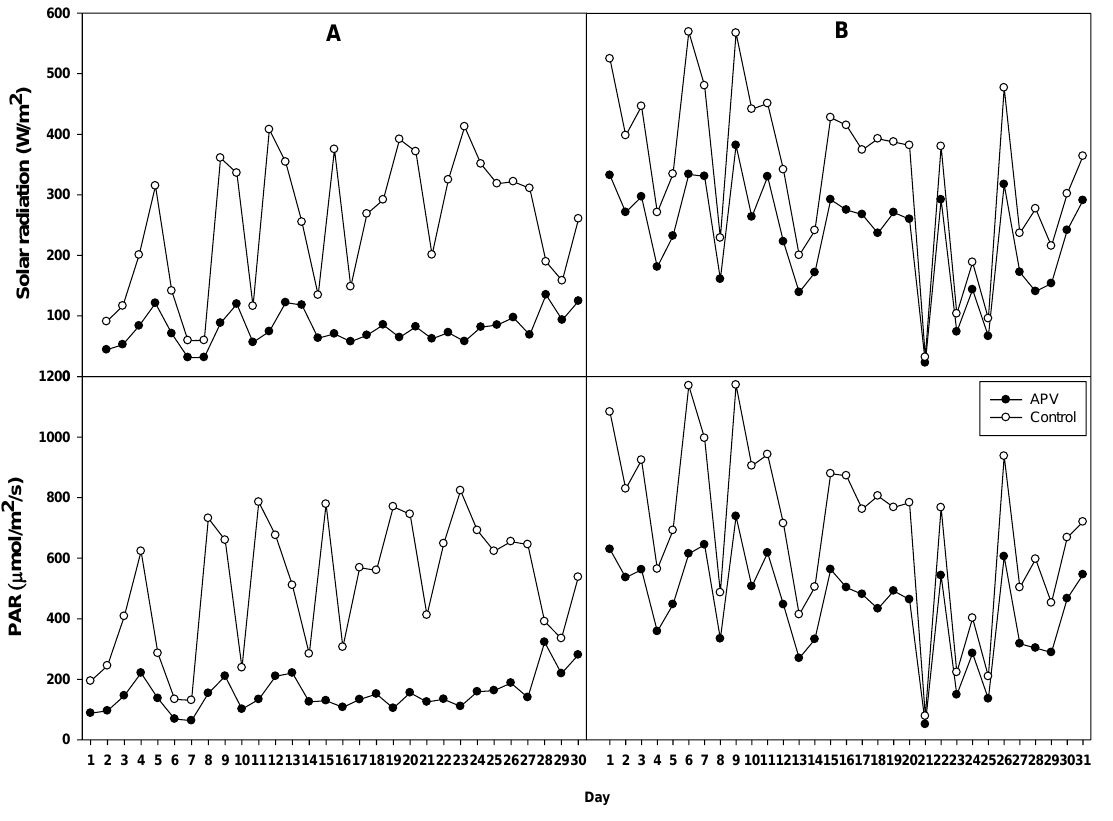
Figure 7. Solar radiation and PAR underneath APV stems in Seungju ( A , September) and Boseong ( B , August), South Korea.